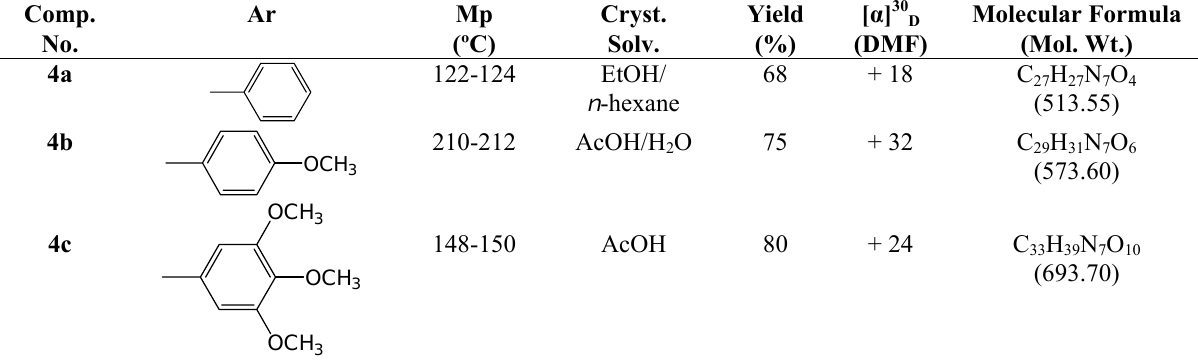
Table 2. Melting points, crystallization solvents, yields, specific rotation, molecular formulae and molecular weights of compounds 4a-h and 5a-h .